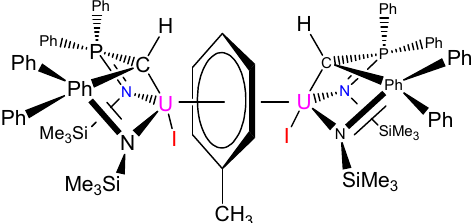
Figure 3. Structure of the arene-bridged uranium(III) (BIPM TMS H)(I)} 2 ( μ - η 6 : η 6 -C 6 H 5 Me)] SMM [60].